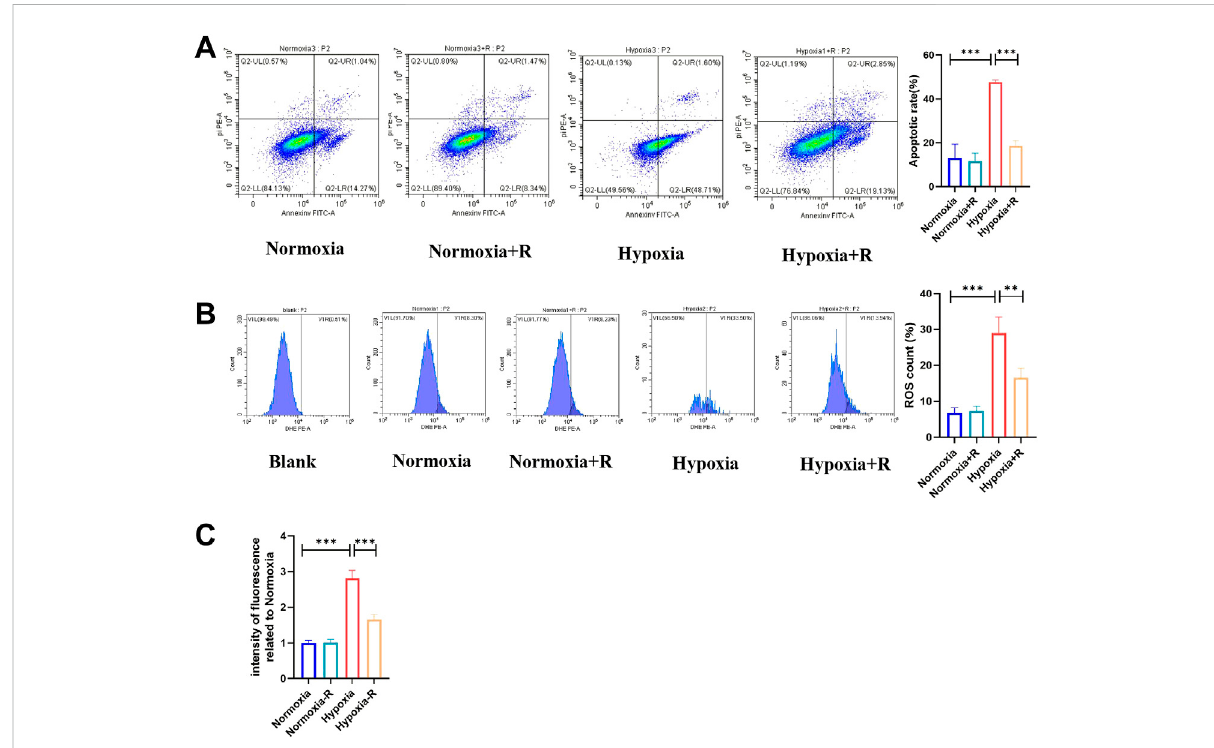
FIGURE 8 RSYRD can reduce the apoptosis rate and ROS production of NMCMs stimulated by hypoxia. (A) The apoptosis rate of NMCMs in four groups (mean ± SD, n = 3). (B) ROS production of NMCMs in four groups (mean ± SD, n = 3). (C) ROS fl uorescence intensity of NMCMs in four groups measured by a microplate reader (mean ± SD, n = 8). **, p < 0.01; ***, p <